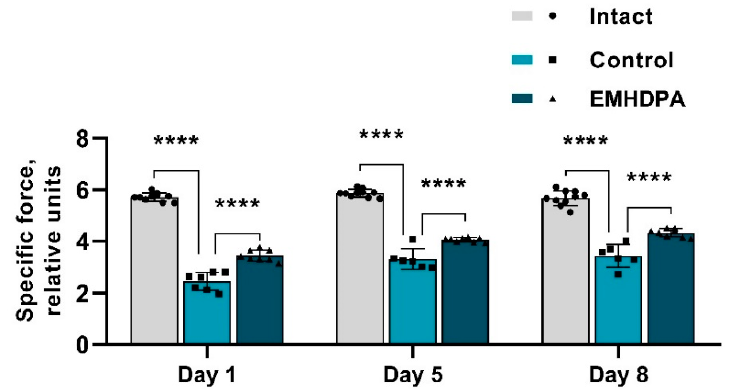
Figure 4. Dynamics of the indicators of specific force in the studied groups. Note: ****— p < 0.0001; 1—intact group; 2—control group; 3—group administered with EMHDPA 25 mg/kg. In the group administered with EMHDPA, total activity was higher on day 1 by 72.7%, on day 3—by 42.9%, on day 10—by 54.3% compared to the control group ( p < 0.05) (Figure 5).